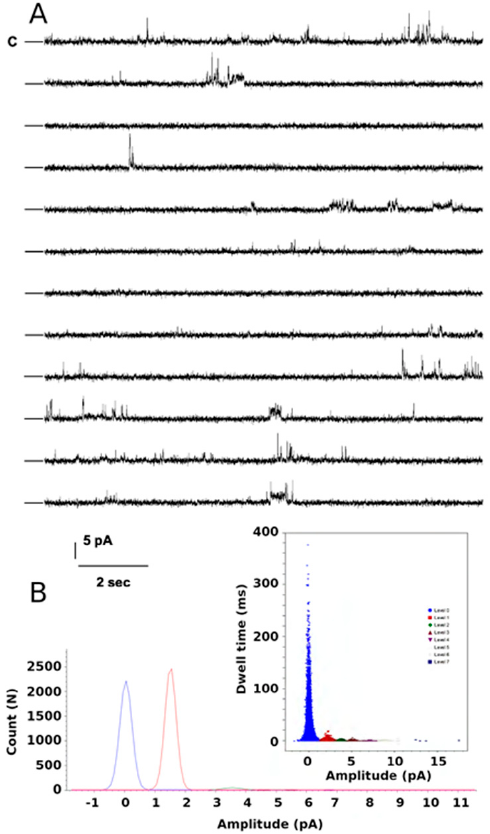
Figure 8. Single-channel recordings of the Kirbac W46R channels. ( A ) Current traces from 3 min consecutive recordings at +100 mV test potential. The closed state is labeled as C. ( B ) Amplitude histogram fits of all events for the selected seven levels gating between closed and open states during 3 min. Inset shows current amplitude values versus dwell time for all seven levels.